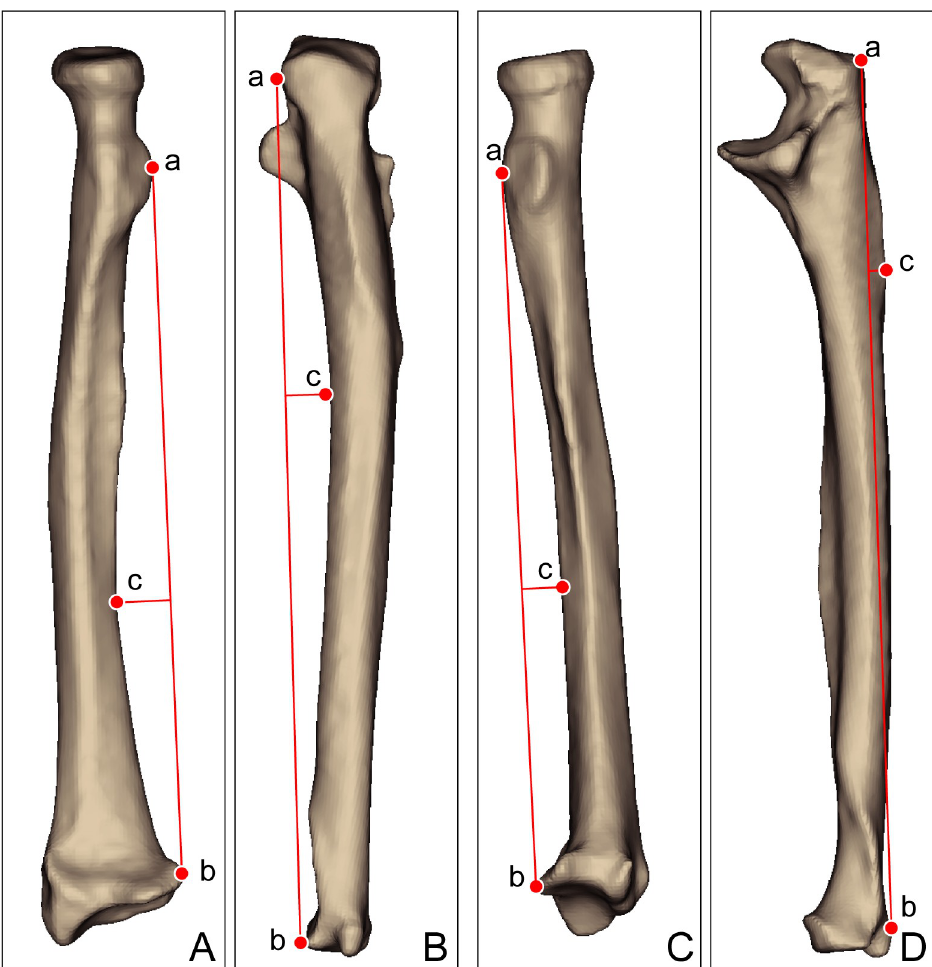
Fig 2. Measurement of forearm bone bowing. The a-b line is defined as ‘bow length’, the location of point c on the a- b line is defined as ‘bow location’, and the distance from line a-b to point c is defined as ‘bow depth’. (A) Coronal bowing measurement of the radius. a, the most ulnar aspect of the bicipital tubercle; b, the most ulnar aspect of the articular surface; c, the farthest radial concavity point from the a-b line. (B) Coronal bowing measurement of the ulna. a, the most prominent ulnar point on the olecranon process; b, the most ulnar aspect of the ulnar head; c, the farthest ulnar concavity point from the a-b line. (C) Sagittal bowing measurement of the radius. a, the most bolar aspect of the bicipital tubercle; b, the most bolar aspect of the articular surface; c, the farthest radial concavity point from the a-b line. (D) Sagittal bowing measurement of the ulna. a, the tip of the olecranon; b, the most dorsal aspect of the ulnar styloid process; c, the farthest ulnar concavity point from the a-b